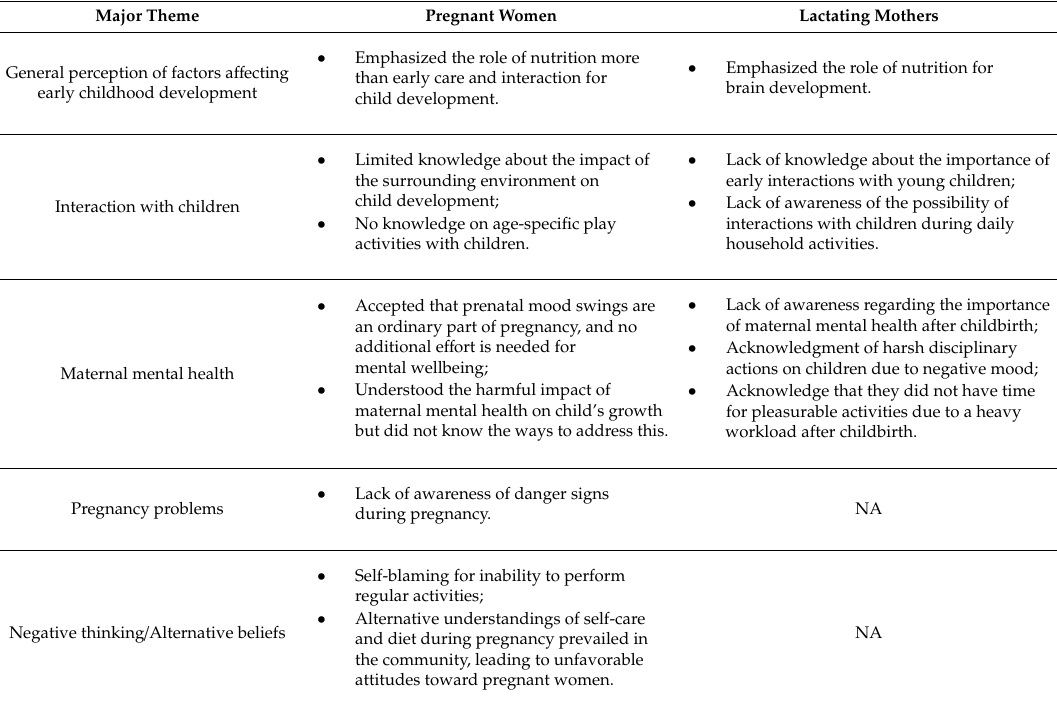
Table 2. Major findings of small group discussion with pregnant women and lactating mothers. Major